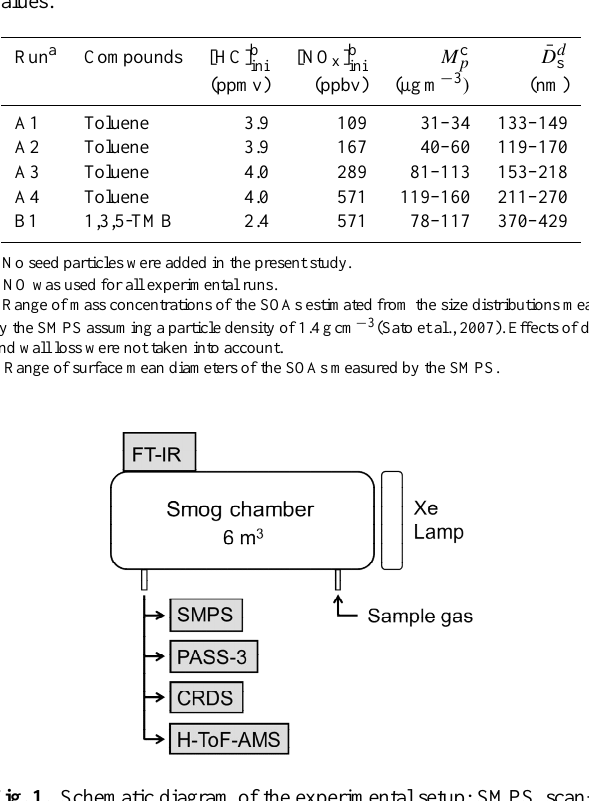
Table 1. Experimental conditions, mass concentrations, and sur- face mean diameters of the SOAs used for determination of the RI- values.